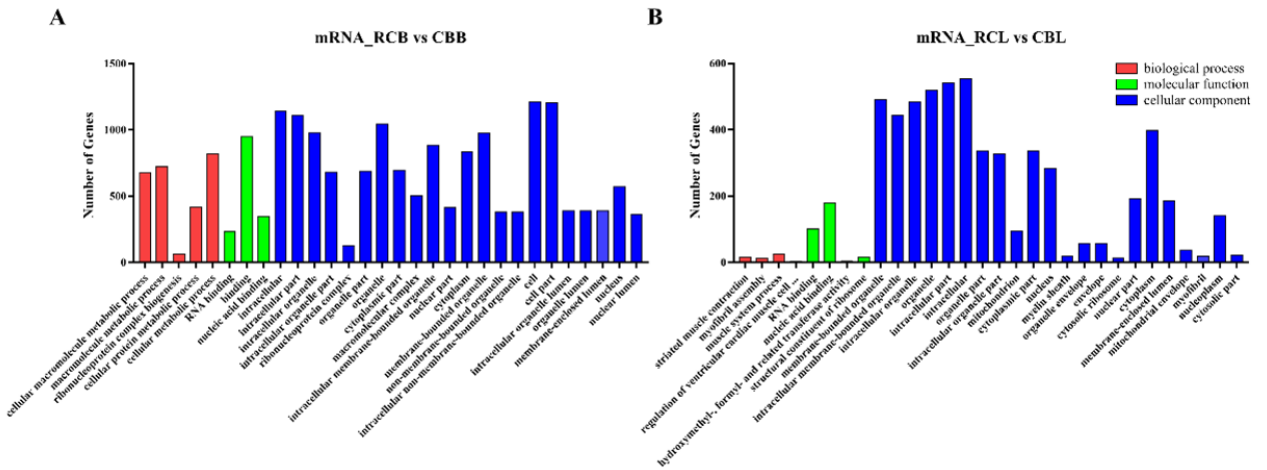
Figure 4. GO and KEGG analysis of differentially expressed mRNAs. (A) and (B) Histogram of the GO enrichment of differentially expressed mR - NAs. Red denotes biological processes, green denotes molecular functions, blue denotes cellular components; the top 30 terms identified in the analysis are displayed. (C) and (D) Scatter plot of the KEGG enrichment of differentially expressed mRNAs. The top 20 terms identified in the anal - ysis are displayed. GO, gene ontology; KEGG, Kyoto encyclopedia of genes and